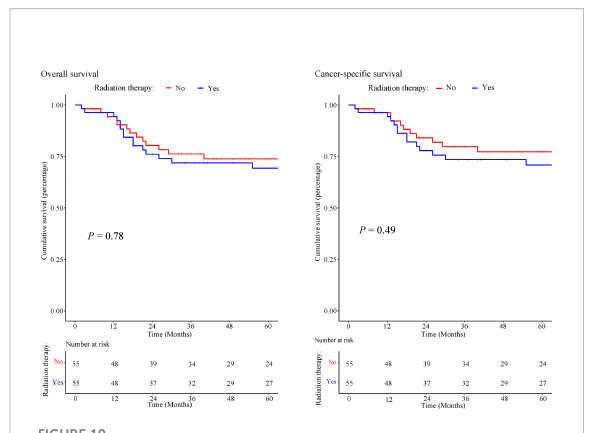
FIGURE 10 Kaplan-Meier of overall survival and cancer-speci fi c survival in patients treated with or without